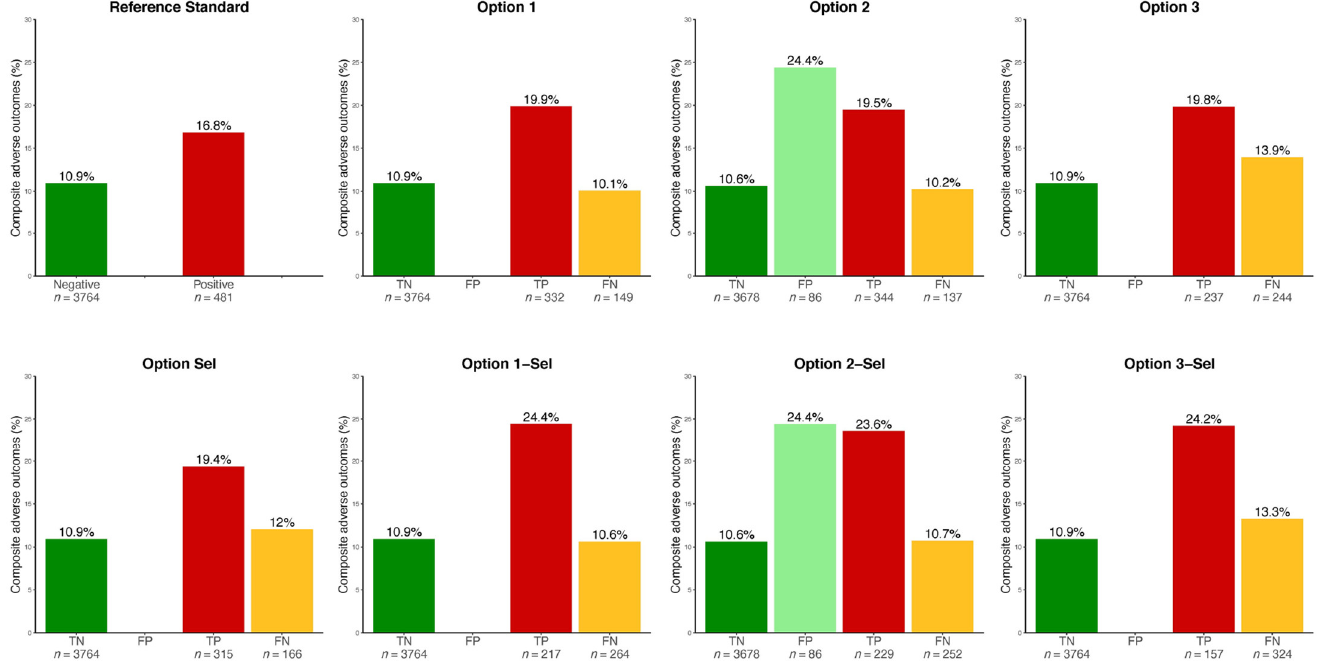
Figure 2. Rate of hyperglycemia in pregnancy-related events by true/false positive/negative cases by each option. Please see description of each option in Figure 1. TN, FP, TP, FN: true negative, false positive, true positive, false negative of hyperglycemia in pregnancy, respectively. HIP-related events: hyperglycemia in pregnancy-related events (composite: preeclampsia or large for gestational age infant or shoulder dystocia or neonatal hypoglycemia). Note that TP and FN cases had been treated for HIP in this observational cohort, whereas TN and FP cases had not.